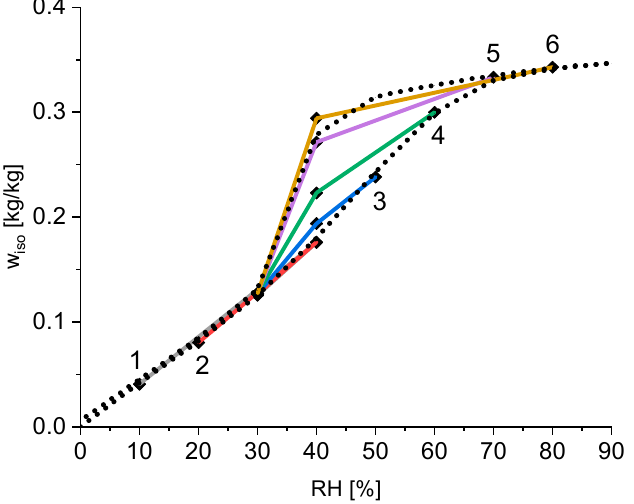
Figure 4. Calculated equilibrium water content of the silica gel for each subset of the experiment (points) and the measured reference isotherm (dotted line); each coloured lines connects the point of one subgroup.